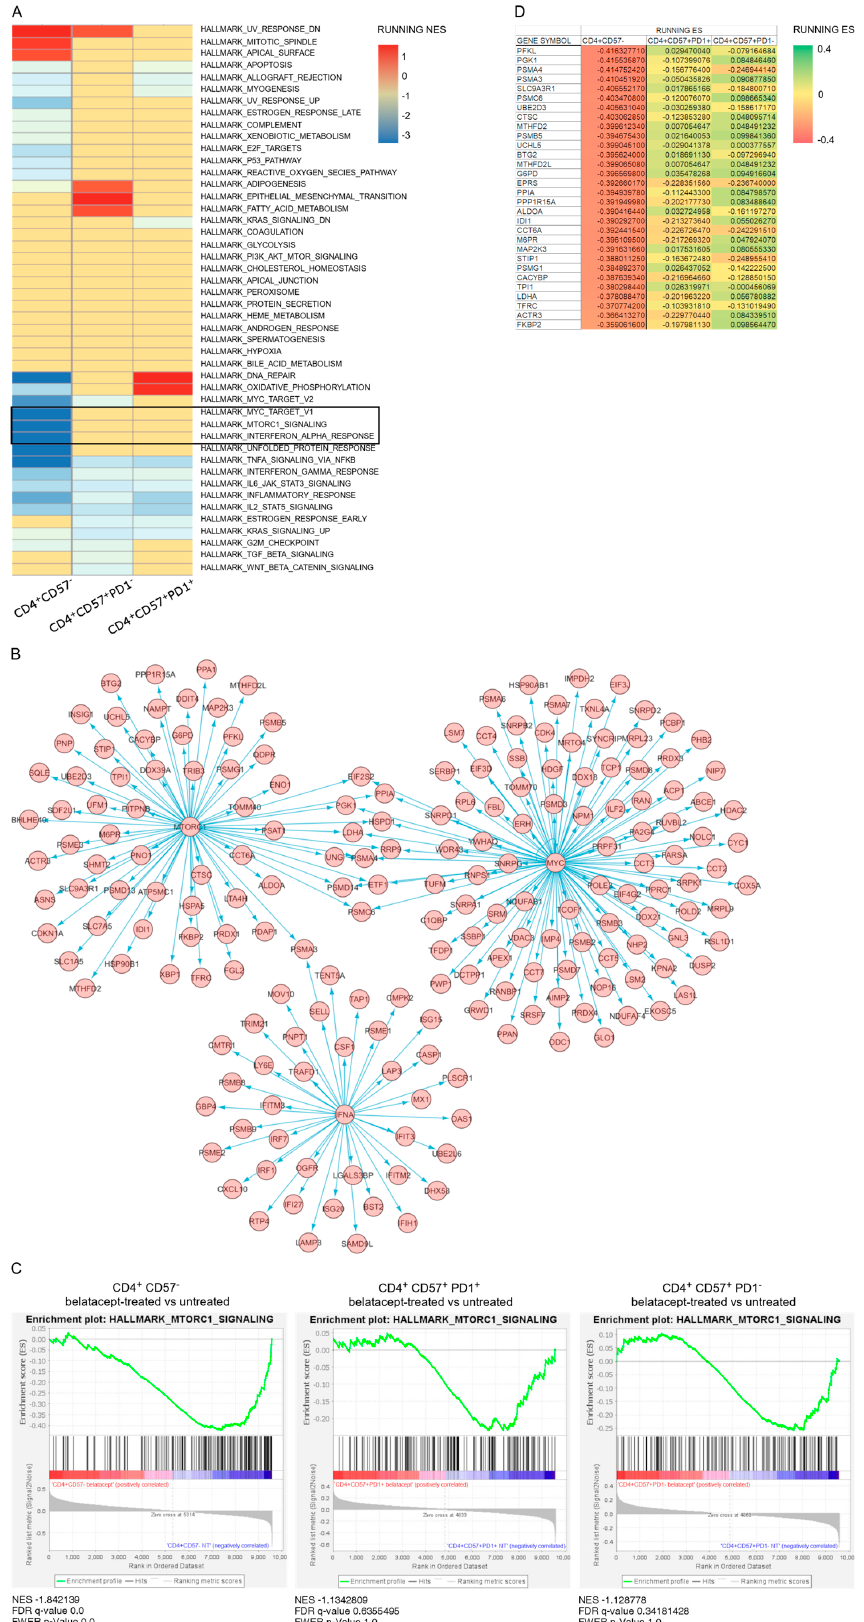
Figure 2. Transcriptomic analysis of the effect of belatacept on CD4 + CD57 − , CD4 + CD57 + PD1 − and CD4 + CD57 + PD1 + allogeneic T cells after 6 h of culture with activated dendritic cells. ( A )